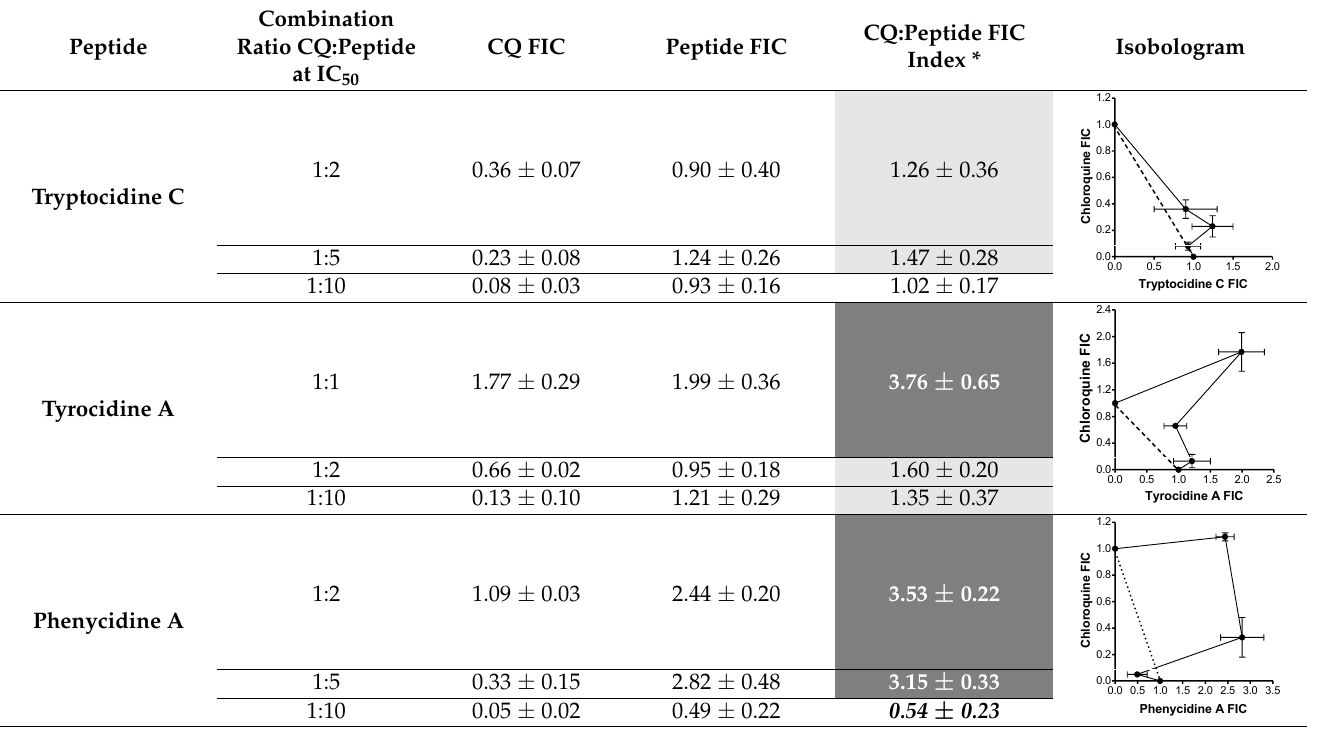
Table 2. Summary of in vitro interaction between chloroquine and Trc A, Phc A and Tpc C in different combinations towards CQI P. falciparum D10. FICs in terms of intra-erythrocytic P. falciparum growth inhibition was determined by the Malstat assay and calculated FIC indices were obtained from three biological repeats of experiments carried out in triplicate.